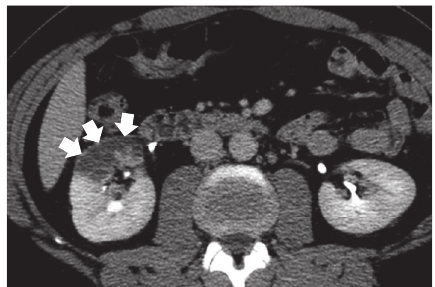
Figure 3: Contrast-enhanced CT scan, axial image, portal phase shows a cuneiform hypodense and nonenhancing area of 5 cm in diameter at the middle-upper pole of the right kidney (arrows).